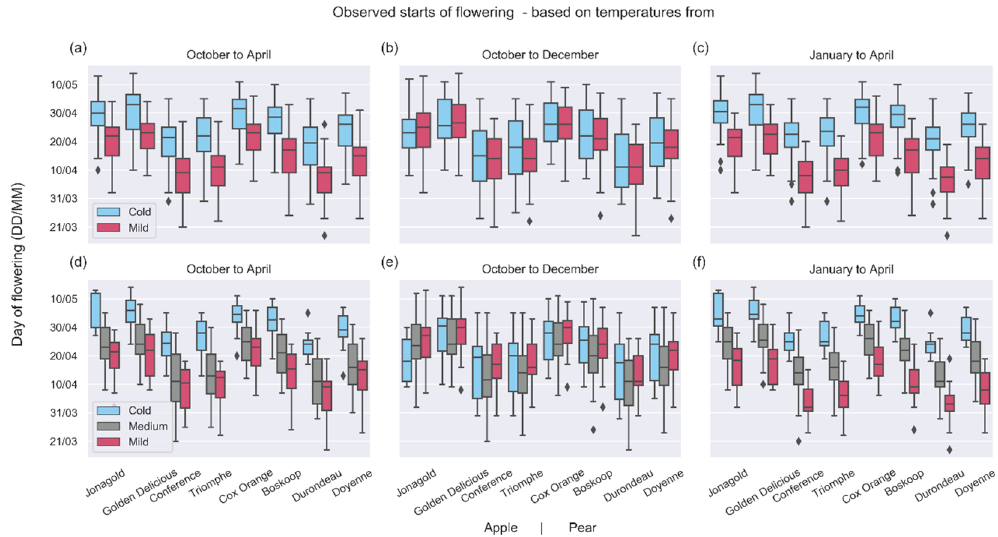
Figure 3. Observed bloom date (DD / MM) of eight cultivars during the ‘full dormancy’ period (panels a , d ), the approximate chilling (panels b , e ), and forcing periods (panels c , f ) presented after segmentation in two halves (34 years each, upper row) or three parts (17–34–17 years each, lower row). Diamonds depict outliers, defined as outside 1.5 times the interquartile range.